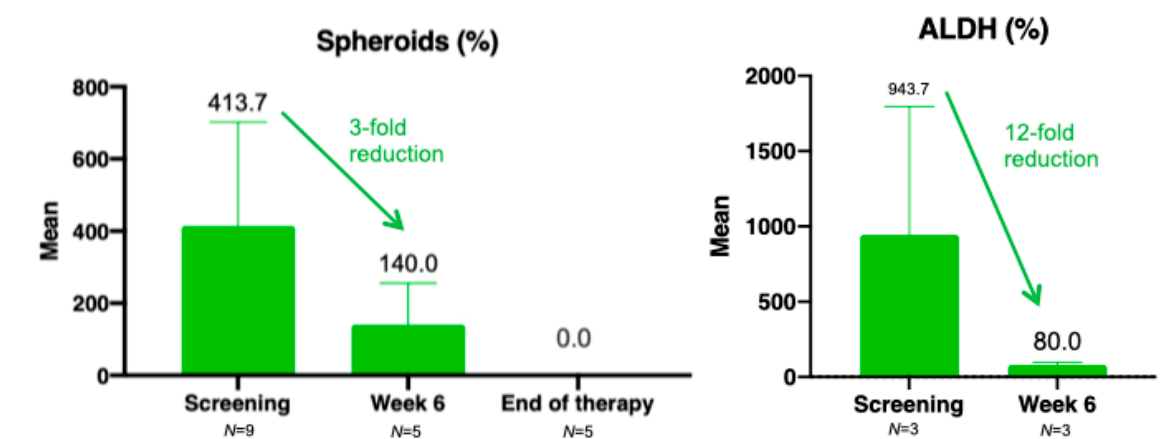
Figure 7. Exploratory analysis of stem cell markers (population: Part A only). ALDH: aldehyde dehydrogenase. Data are plotted as the mean (standard error of the mean). Week 6 = end of Cycle 2.